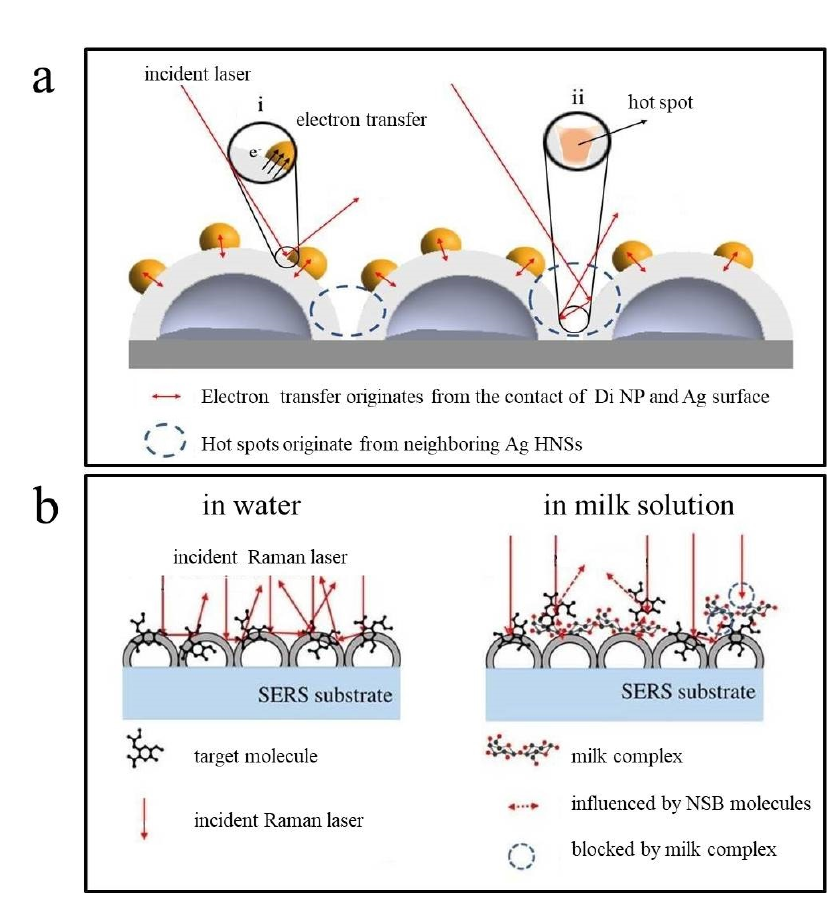
Figure 7. Schematic diagrams of ( a ) the main electromagnetic enhancement areas: when the incident lights are appropriately introduced, (i) electron transfers from the contacts at the interface between Di NPs and Ag surface occur, while (ii) upon Raman-active sites, neighboring Ag shells with cavities form “hot spots” and ( b ) SERS mechanism of Di NPs/Ag HNS with the inclusion of ampicillin in water and in milk solution. Ampicillin molecules in water attach upon Di NPs/Ag HNS, making its SERS-active signals enhanced. In milk solution, NSB molecules are also adsorbed upon Di NPs/Ag HNS, making only a part of Ampicillin molecules attach to the surfaces of Di NPs/Ag HNS. In the practical cases, a milk solution contains many NSB molecules that may hinder the absorption of ampicillin to be measured on SERS-active sites and therefore decrease Raman signals, in particular for the main peak at 1007 cm −1 . In Figure 7b, the incident laser interacts with ampicillin on Di NPs/Ag HNS in water and milk solution is illustrated. Ampicillin is expected to attach upon Di NPs/Ag HNS in water, making its SERS-active signals enhanced. In milk solution, non-target or NSB molecules such as the residues of sugar and protein are also adsorbed upon Di NPs/Ag HNS,